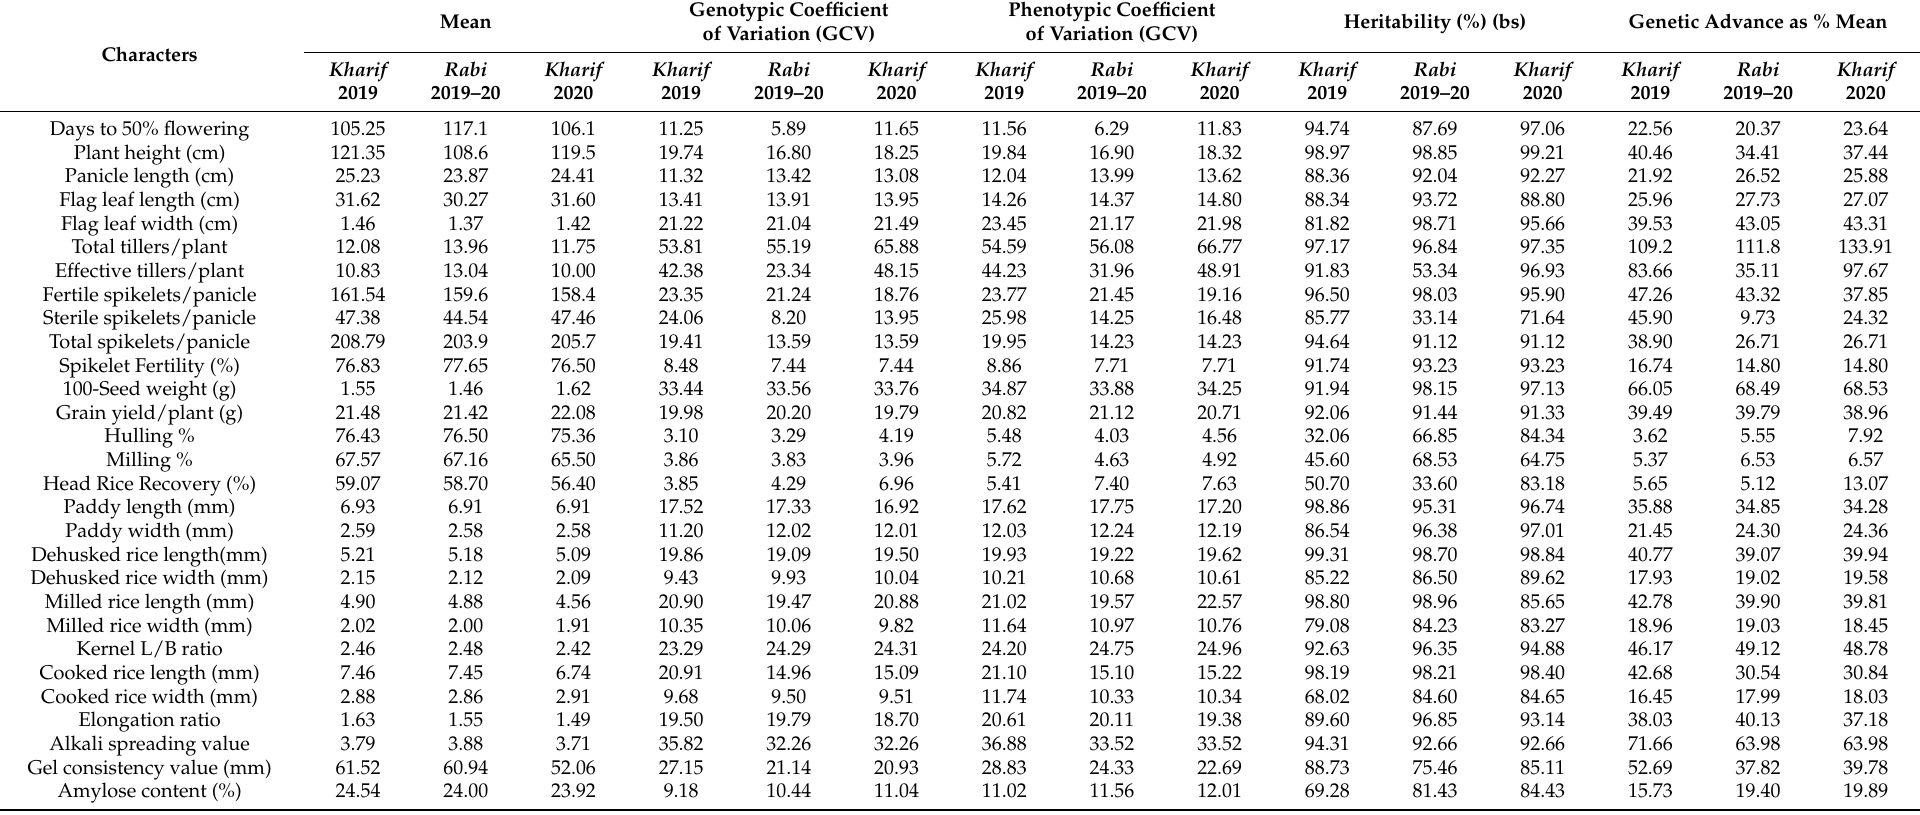
Table 4. Parameters of the genetic variability based on the agro-morphological and grain quality traits.